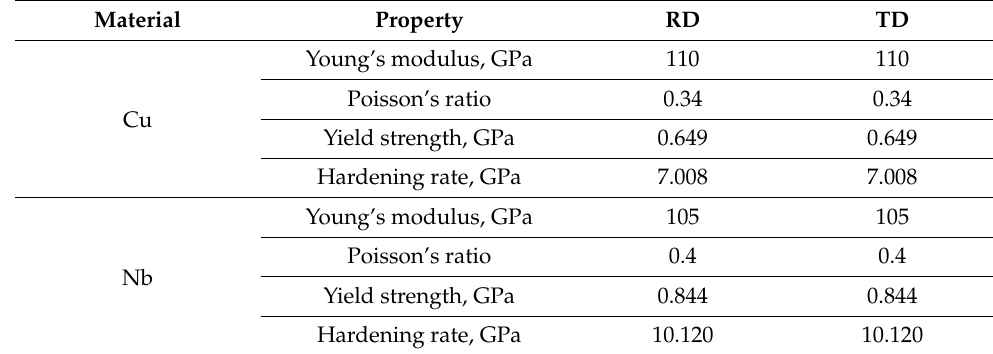
Table 1. The properties of the Cu and Nb layers used in the nanoindentation simulation.